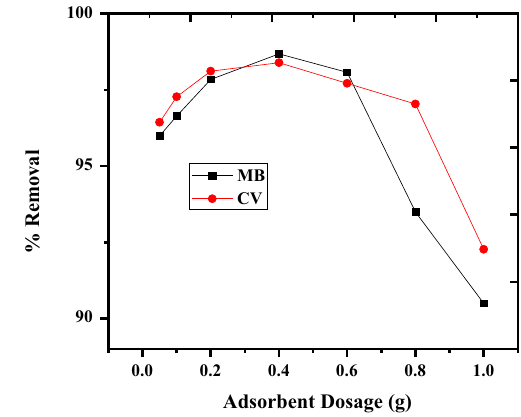
Fig. 7 The influence of adsorbent dosage on the removal efficiency CV and MB by MSH